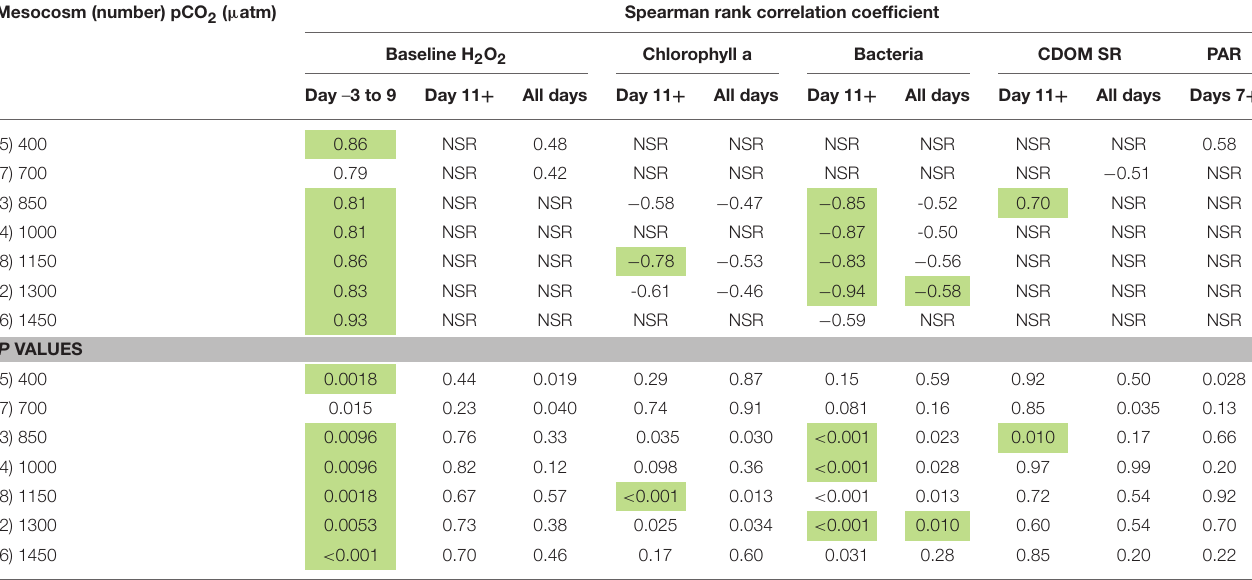
TABLE 2 | Spearman rank correlation coefficients and p values for H 2 O 2 concentration time series in each mesocosm compared to: baseline H 2 O 2 concentration in ambient seawater (nM), chlorophyll a ( µ g L − 1 ), total bacteria (cells mL − 1 ), colored dissolved organic matter slope ratio (S R ), and daily integrated mean photosynthetically active radiation (PAR, W m − 2